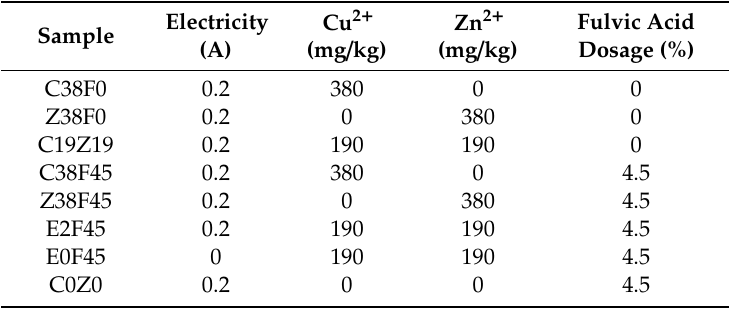
Table 2. Experiment scheme for heavy metal ion electroosmotic migration.